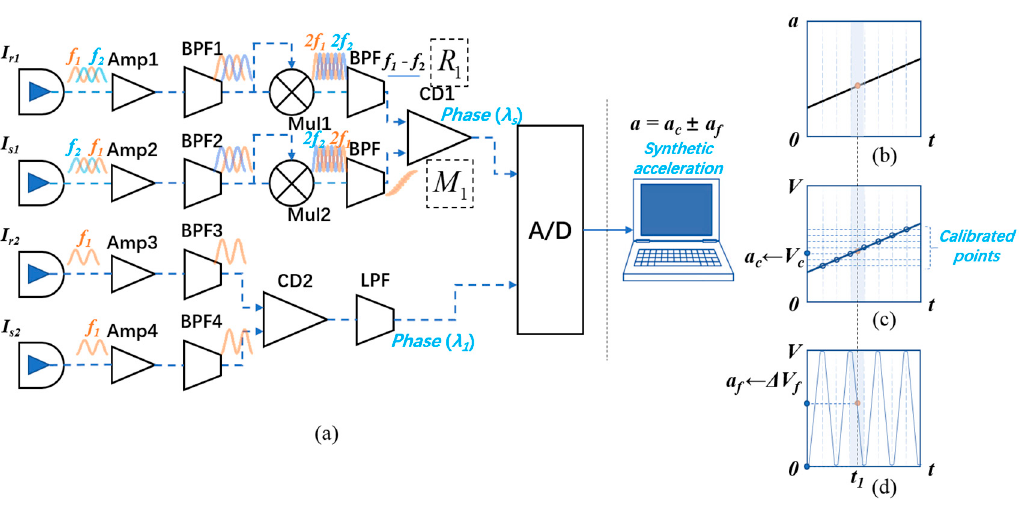
Figure 2. ( a ) Sketch of the signal processing circuit, including amplifiers, band pass filters, self-mixers, and coherent-demodulators. ( b ) Original linear acceleration as a function of time. ( c ) Phase output via the ruler of the synthetic wavelength as a function of time. ( d ) Phase output via the ruler of the single wavelength as a function of time.